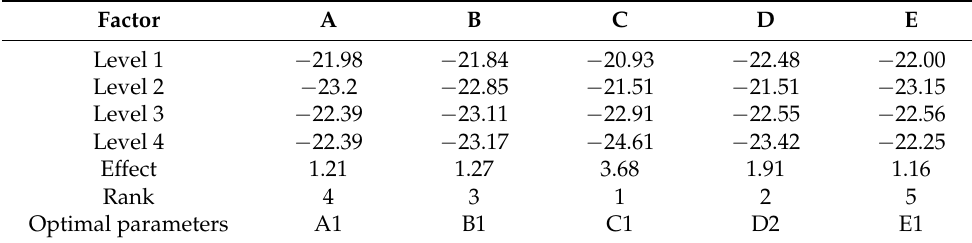
Table 11. Average Temperature Difference Response.